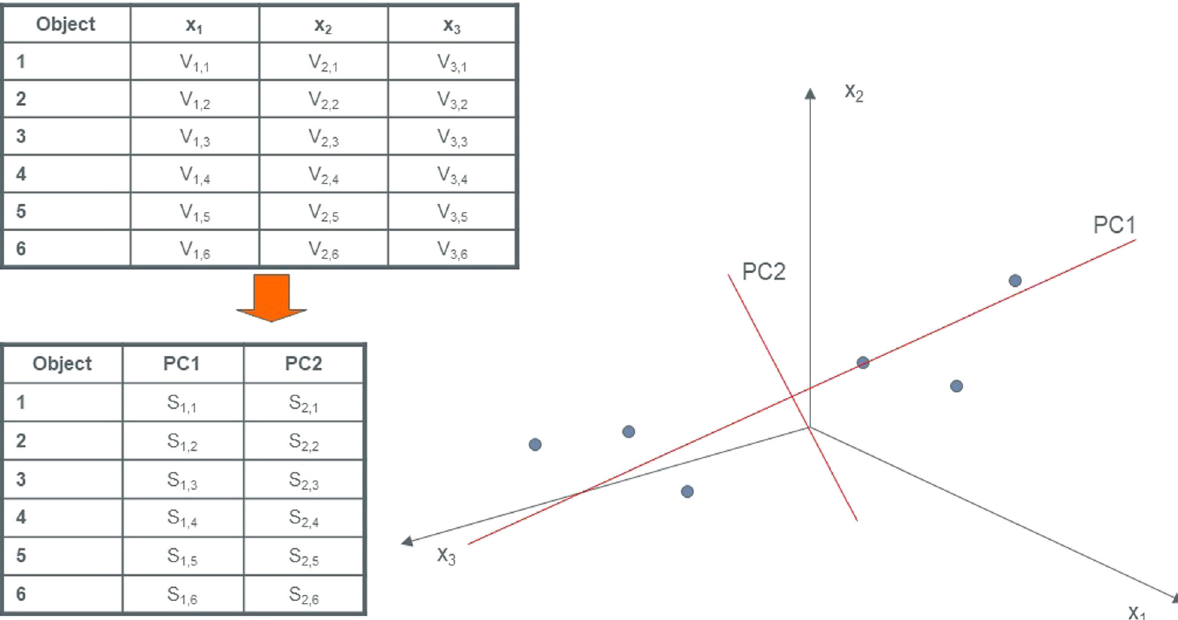
Figure 2: The principle of a PCA